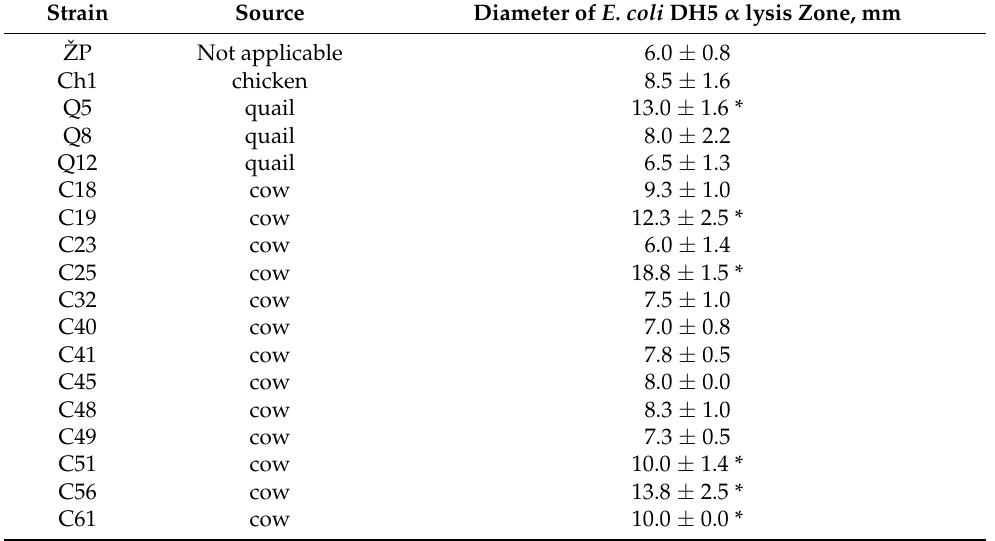
Table 2. Screening for the bacteriocin-producing E. coli by the agar overlay